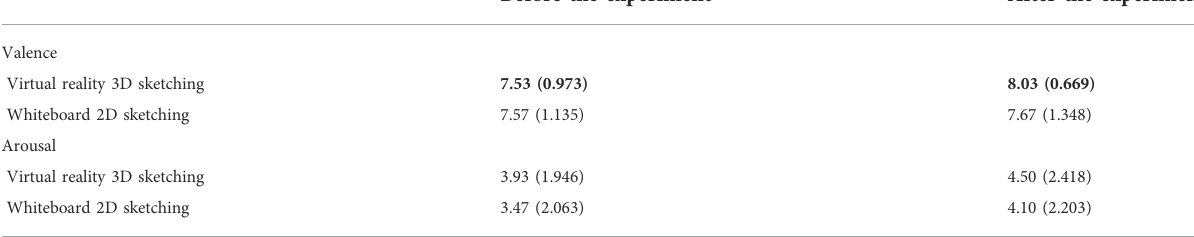
TABLE 1 Means and standard deviations (between brackets) for the reported level of arousal and valence (before and after the experiment) concerning the two conditions.